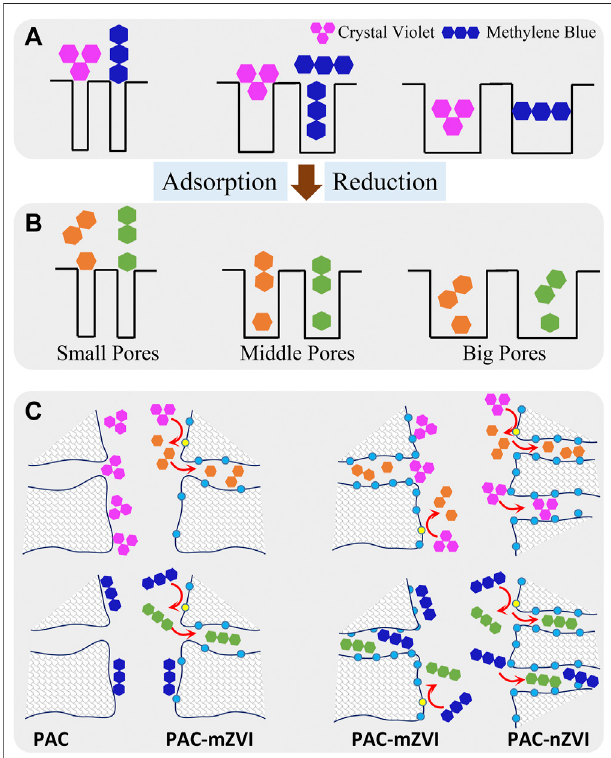
FIGURE 9 | A model of dye molecule (CV, MB) removal process by PAC and PAC-based ZVI adsorbents.